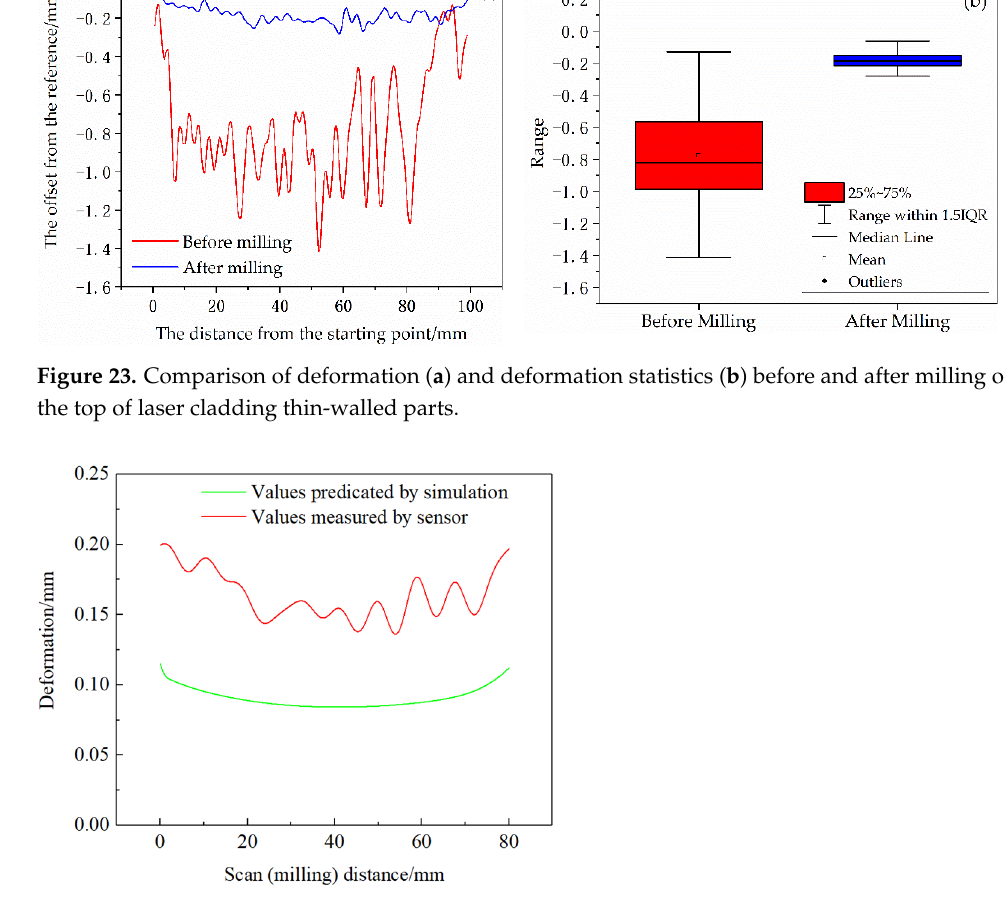
Figure 24. Comparison of the predicted and measured deformation of thin-walled parts after mill-